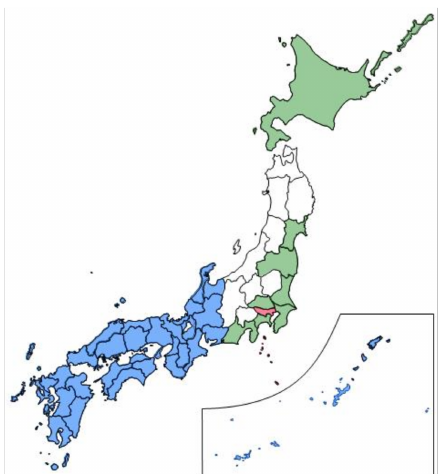
Figure 1. Map of the 47 prefectures in Japan. Red—Tokyo (host city); Green—prefectures where the Tokyo 2020 games were held; Blue—donor pool (29 prefectures west of Toyama, Gifu, and